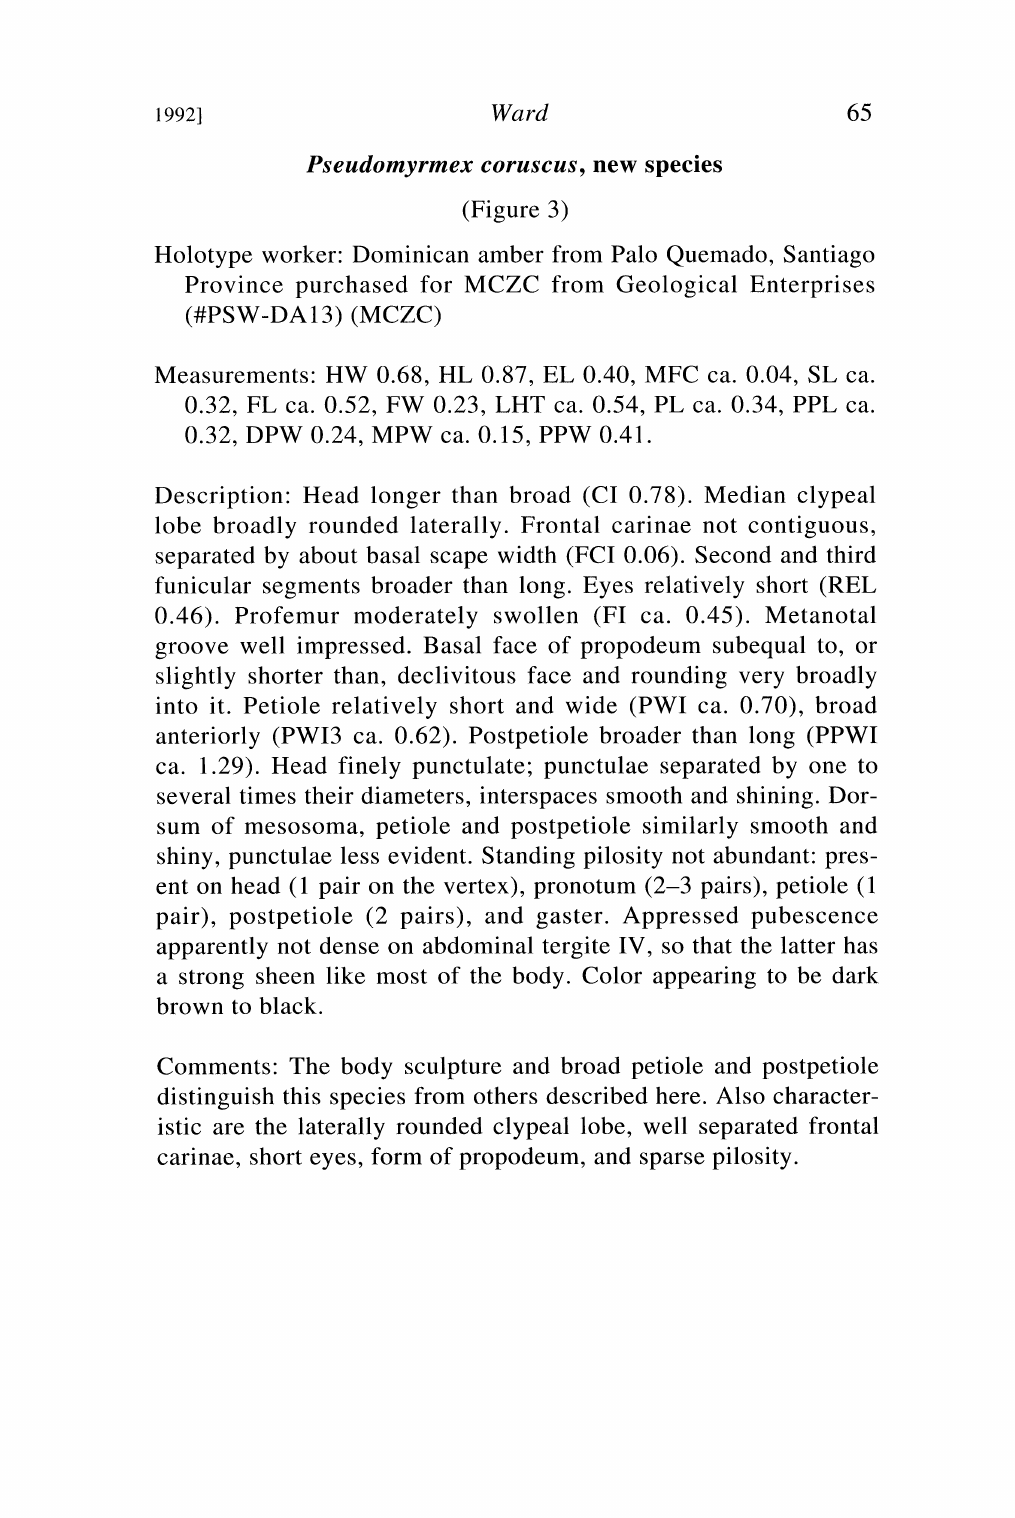
Holotype worker: Dominican amber from Palo Quemado, Santiago Province purchased for MCZC from Geological